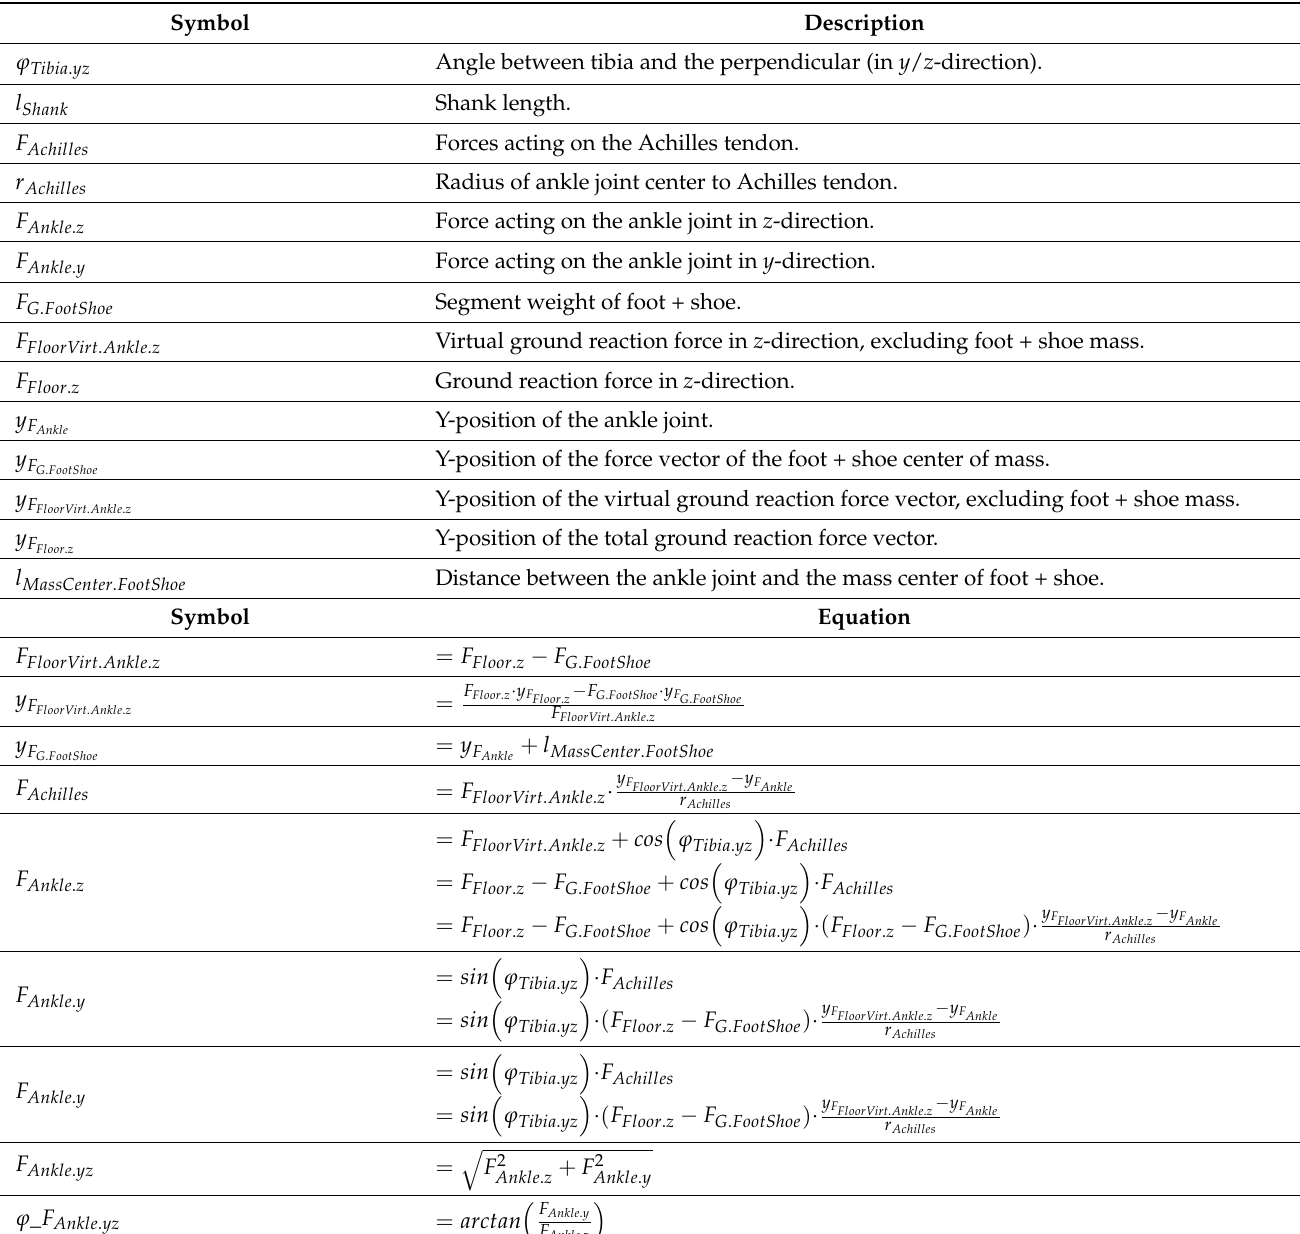
Table A2. Symbols with description and Equations as used for the model displayed in Figure A1. Symbol